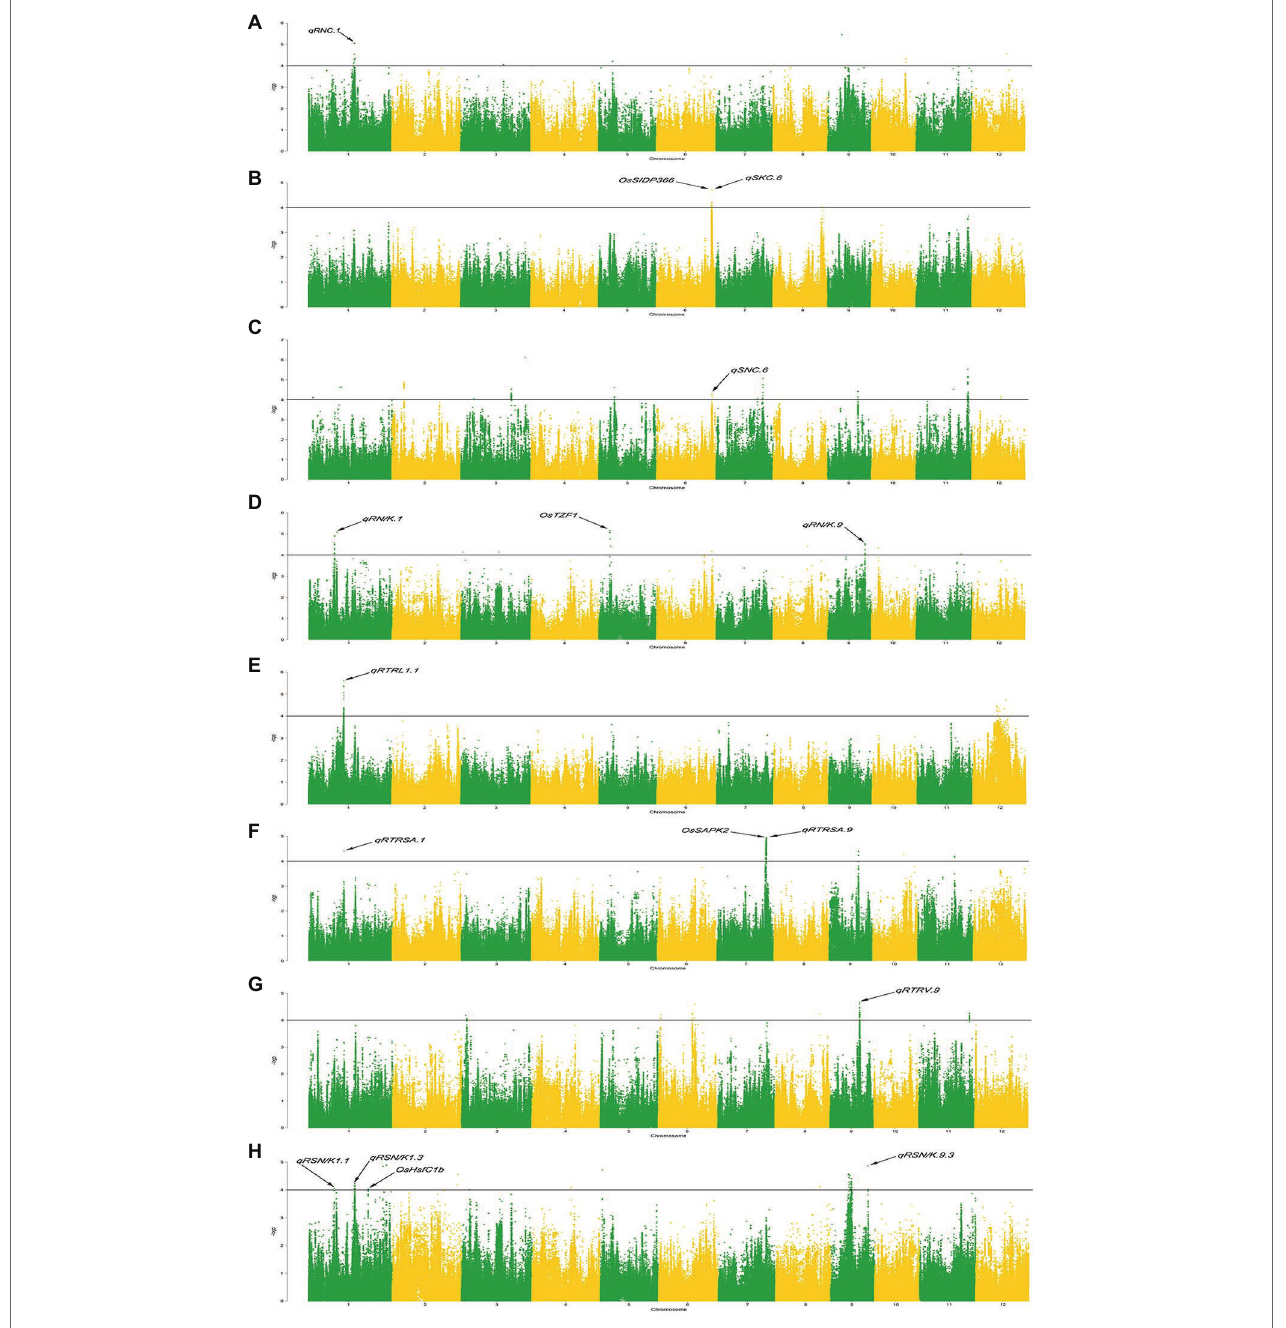
FIGURE 1 | Manhattan plots of genome-wide association studies. (A-H): Manhattan plots for the RNC (root Na + concentration), SKC (shoot K + concentration), SNC (shoot Na + concentration), RN/K (ratio of Na + to K + concentrations in roots), RTRSA (relative total root surface area), RTRV (relative total root volume), RTRL (relative total root length), and RSN/K (relative ratio of Na + to K + concentrations in